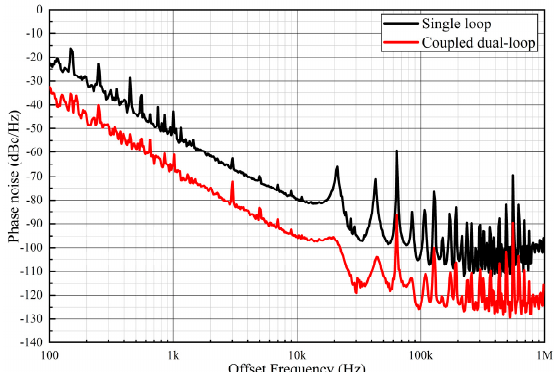
Figure 6. The 10 GHz microwave signal phase noise comparison between single loop SBS-based TOEO and the coupled dual-loop SBS-based TOEO.